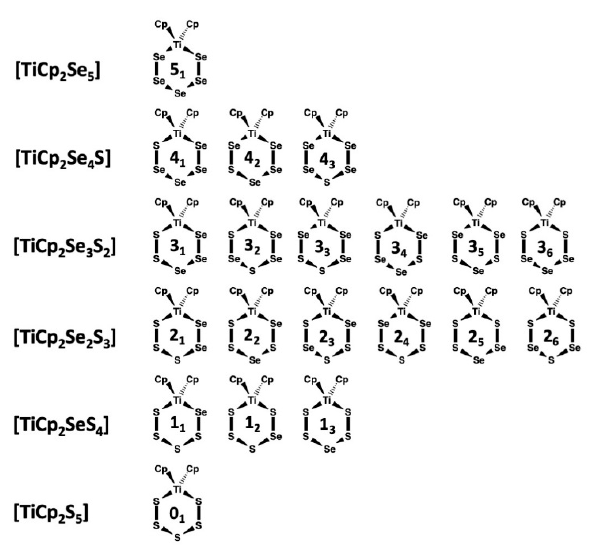
Figure 1. Possible isomers of [TiCp 2 Se x S 5 − x ] ( x = 0–5).